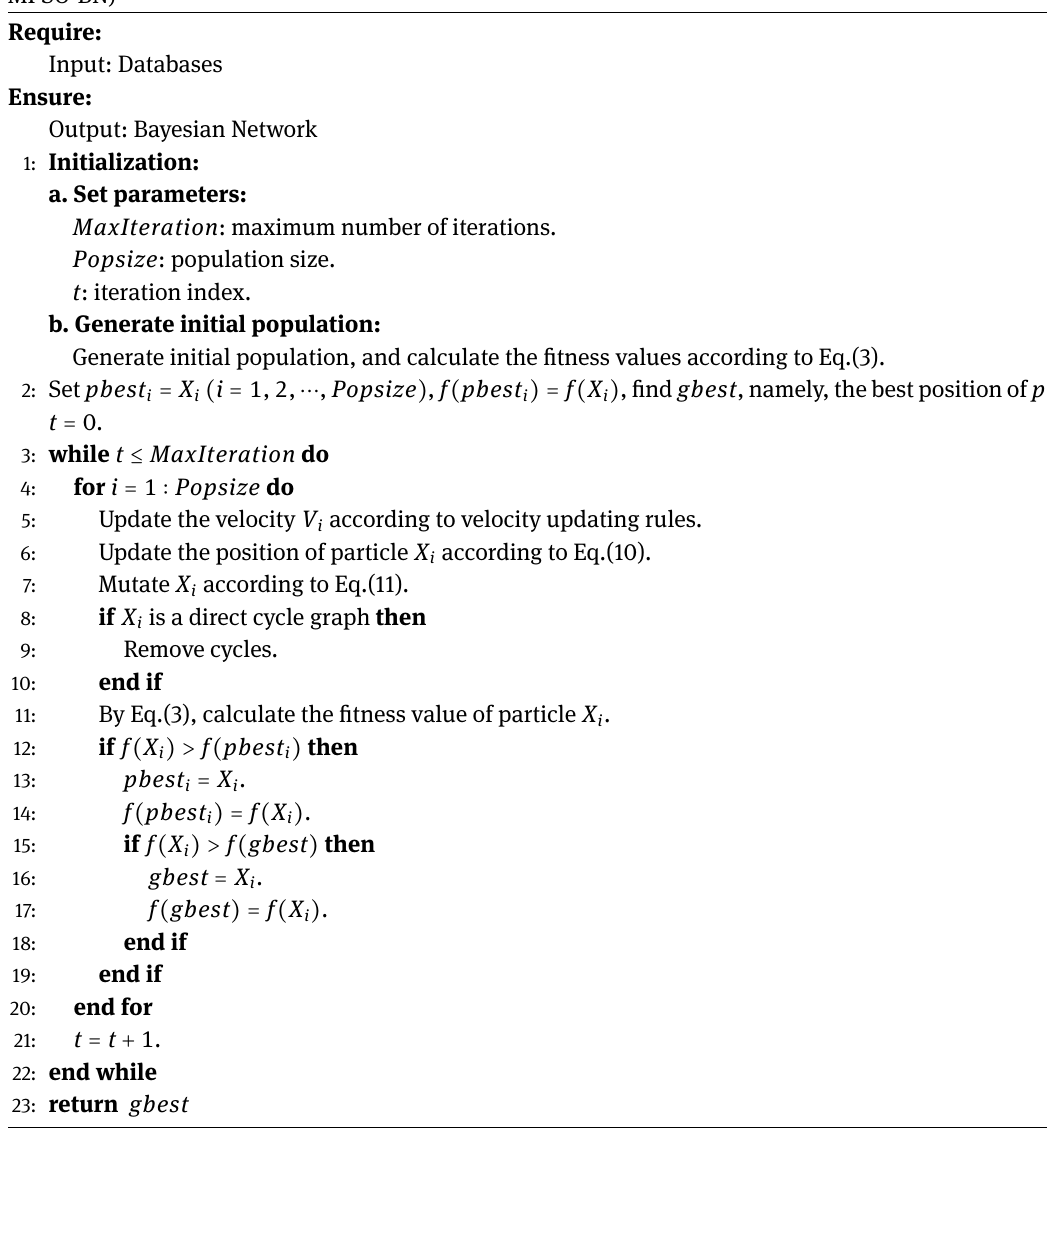
Algorithm 1 Learning Bayesian Networks Based on Bi-Velocity Discrete PSO with Mutation Operator (BVD-